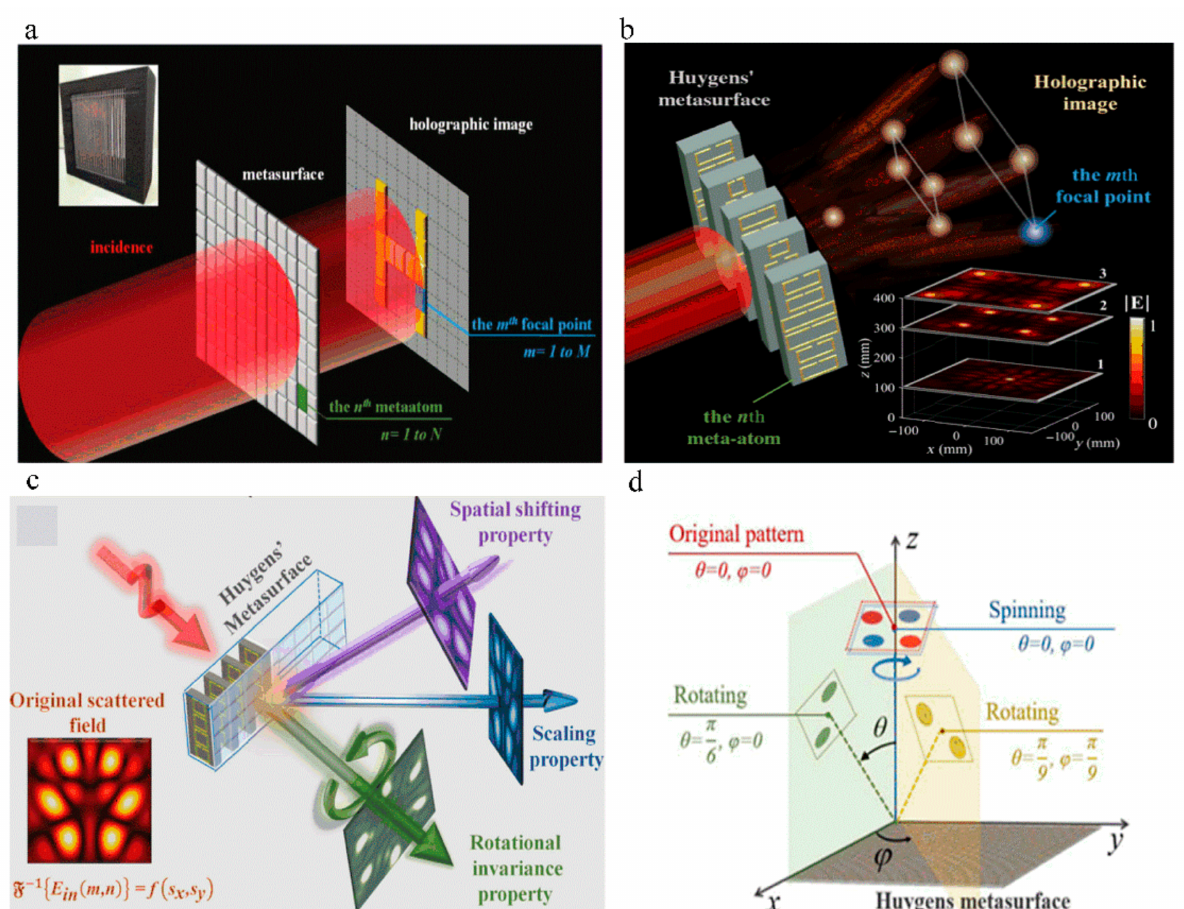
Figure 5. Huygens’ metasurface design and some application examples. ( a ) Schematic diagram of the proposed Huygens’ metasurface hologram for imaging with the desired focal intensity distribution. Reprinted with permission from ref. [105]. Copyright 2018 John Wiley and Sons. A photograph of the fabricated sample is shown in the upper left insert. ( b ) Illustration of the hologram structure and the reconstruction procedure of the microwave 3D imaging utilizing Huygens’ metasurface. Reprinted with permission from ref. [107]. Copyright 2020 American Physical Society. ( c ) A frequency-domain modulating metasurface performing Fourier transform properties. Adapted with permission from ref. [108]. Copyright 2020 Springer Nature. ( d ) Schematic diagram of the spatial rotation operations. Reprinted with permission from ref. [109]. Copyright 2019